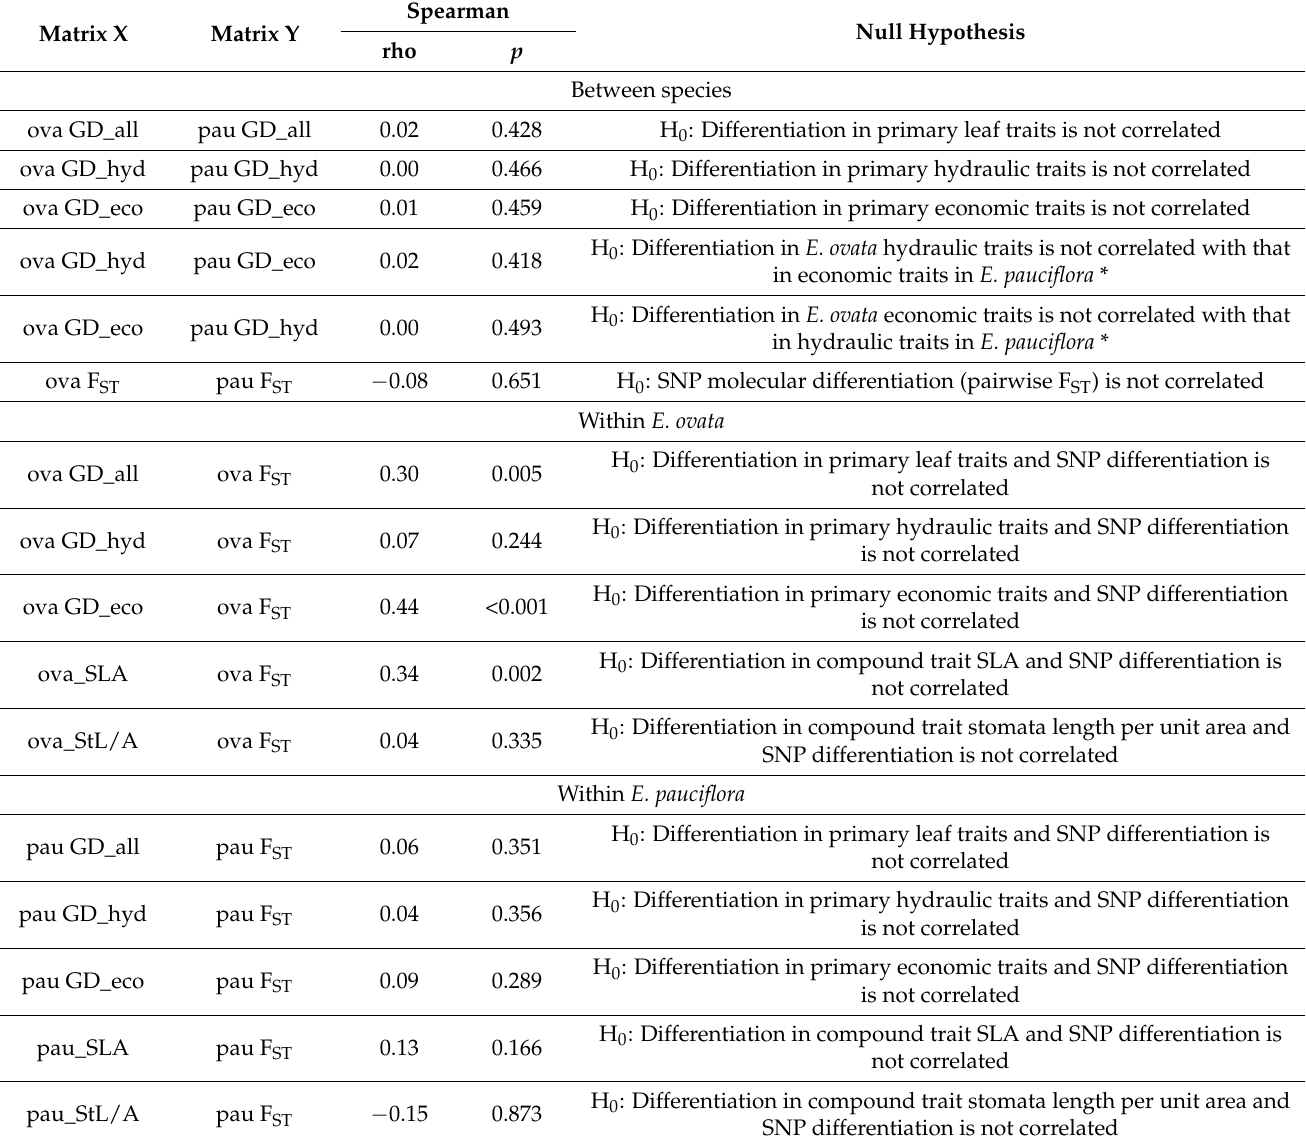
Table 5. Mantel’s correlations (rho = Spearman correlation) among molecular (F ST ) and (i) quantitative (generalized distances, GD) matrices of pairwise differences and (ii) the differences among population means of specific leaf area (SLA) and stomatal length per area (StL/A) of E. ovata (ov) and E. pauciflora (pau). Results of between- and within-species matrix comparisons are provided. The among-population generalized distance matrices of each species were calculated with all six primary leaf traits (GD_all), or the three hydraulic (hyd) or economic (eco) traits. The significance probabilities ( p ) associated with the null hypotheses (H 0 ) being tested for population differentiation are indicated (21 populations per species for comparisons involving F ST